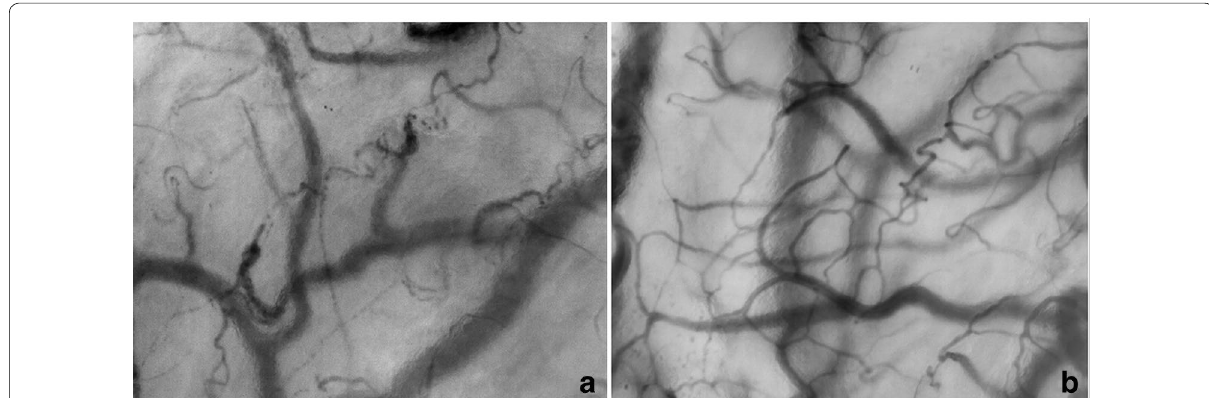
Fig. 1 Sublingual microcirculation of two patients with SARS-COV2 severe pneumonia. Patient ( a ) showed a significantly lower perfused vessel density as compared to patient ( b ). D-dimer levels were 6367 ng/ml in patient ( a ) and 741 ng/ml in patient ( b ). PaO 2 /FiO 2 ratio was 74 mmHg in patient ( a ) and 247 mmHg in patient ( b